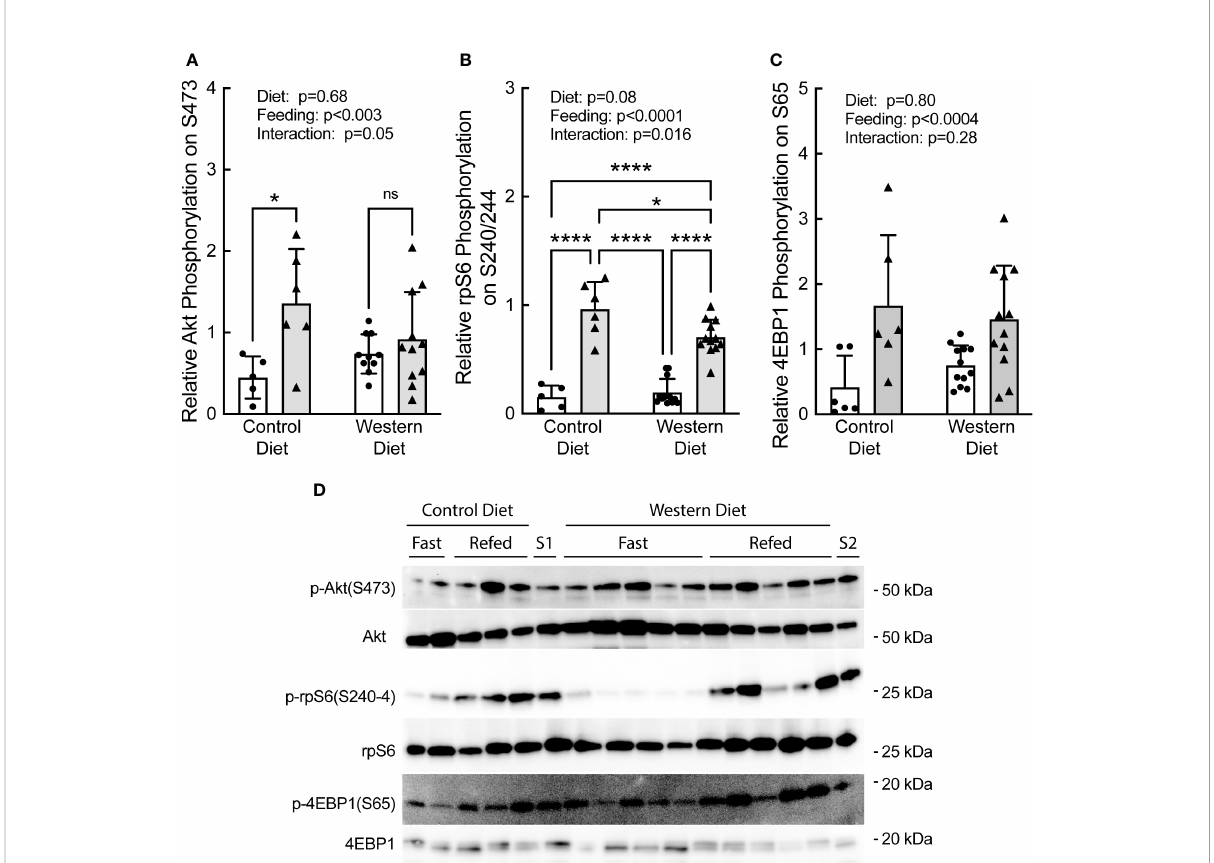
FIGURE 5 Effect of short-term consumption of a Western diet on hepatic (A) Akt, (B) ribosomal protein S6 (rpS6), and (C) 4E-BP1 phosphorylation. (D) Representative blots. S1, liver sample from a refed rat fed a control diet included on each gel as a standard; S2, liver sample from a refed rat fed a WD included on each gel as a standard. N=6-12 rats/group. *p ≤ 0.02, ****p<0.0001. ns, not signi fi